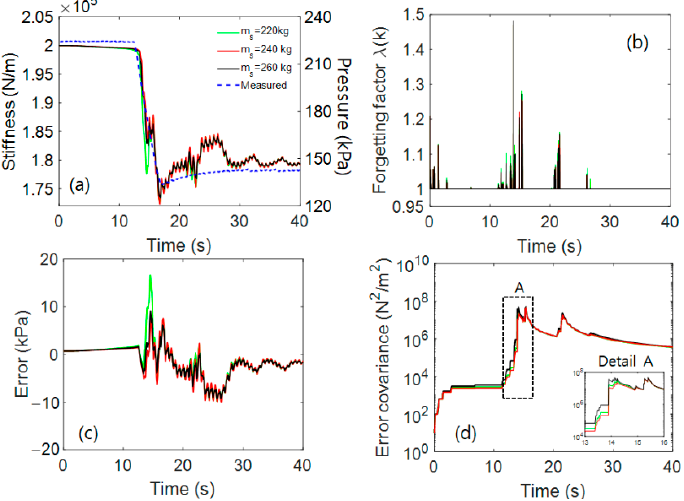
Table 4. Comparison of RMSE for different sprung masses.